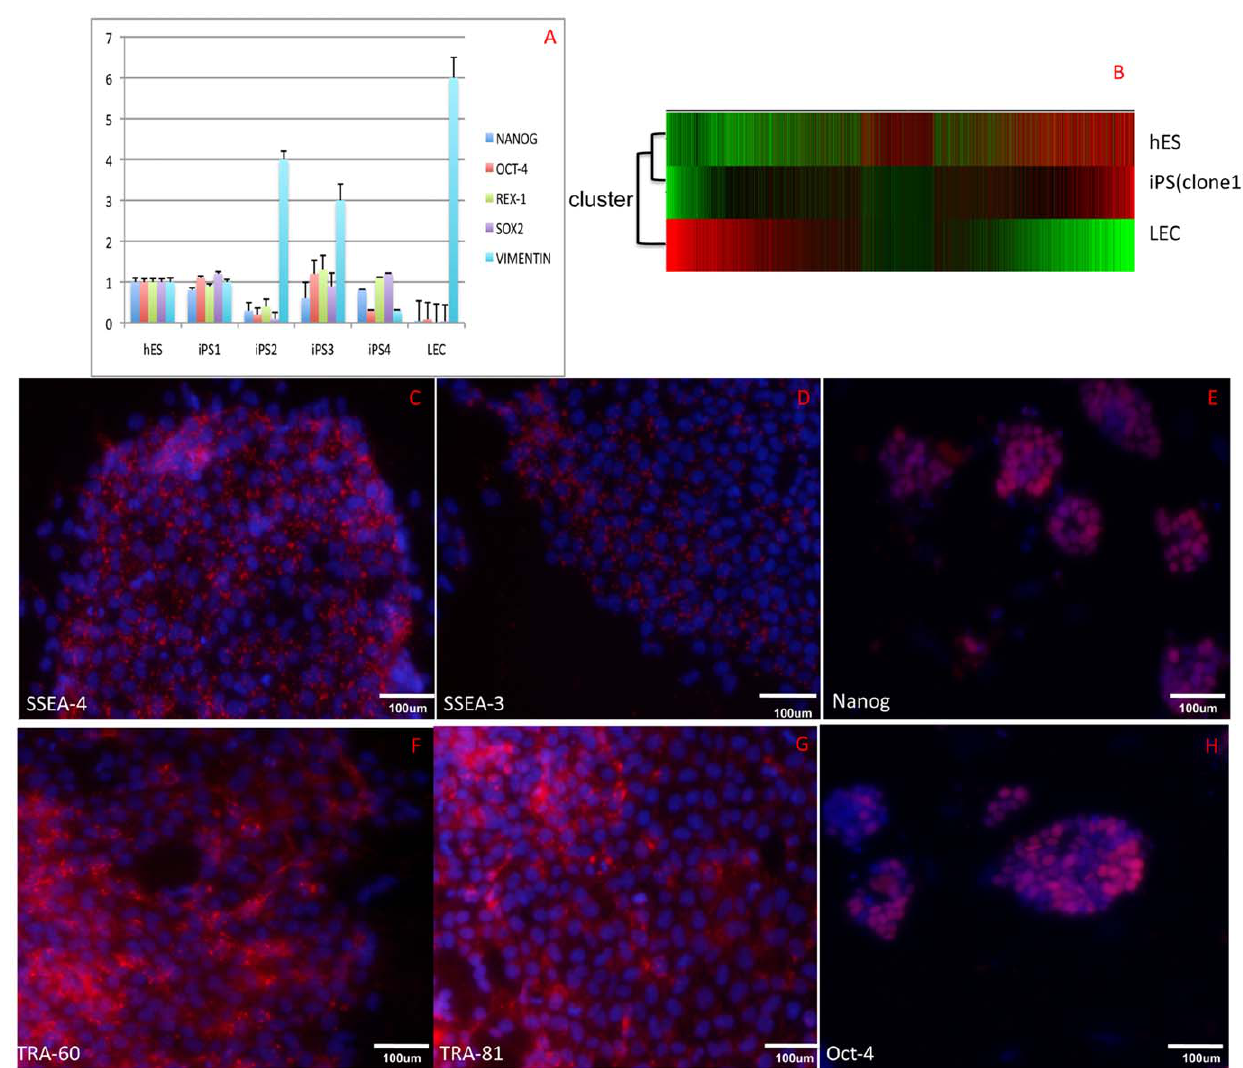
Figure 2. HLEC-iPSCs exhibit key HESC markers and HESC morphology. (A) Real-time RT-PCR analysis of ES markers in HLEC-iPS clones and H9 ES clones. Primers were used that specifically recognize endogenous HESC-specific genes in iPS clones (OCT-4, NANOG, REX-1, SOX-2) and vimentin, which is an HLEC-specific gene. (B) A microarray analysis was performed to compare the gene expression profiles of HLEC-iPSCs, a human H9 ES cell line and primary HLECs. A hierarchical cluster analysis of 8030 orthologous human genes was performed based on the signal ratios. The distances between the genetic profiles of the samples are shown. (C-H): Pluripotency marker staining (red) of the iPS1 clone, (C) SSEA-4, (D) SSEA-3, (E) NANOG, (F) TRA-60, (G) TRA-81 and (H) OCT-4. endodermal (Fig. 3E: AFP) markers representing each embryonic germ layer. Additionally, following transplantation into nude mice, human iPSCs formed teratomas (Fig. 3F) consisting of all three germ layers, including ciliated columnar epithelium (endoderm, Fig. 3G), cartilage islands (mesoderm, Fig. 3H) and primary neural tube (ectoderm, Fig. 3I). Taken together, these results suggest that typical HLEC-iPS cells exhibit the characteristic morphology and key signaling responses of conventional HESCs and can be differentiated into all of the germ lines.